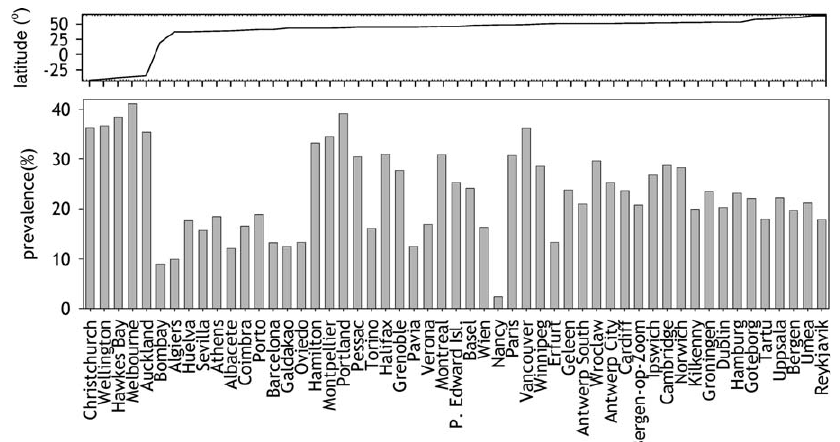
Figure 2. Prevalence of AR in ECRHS I Screening by Centre Centres are sorted by increasing geographical latitudes from left to right. DOI: 10.1371/journal.pmed.0020294.g002 PLoS Medicine |